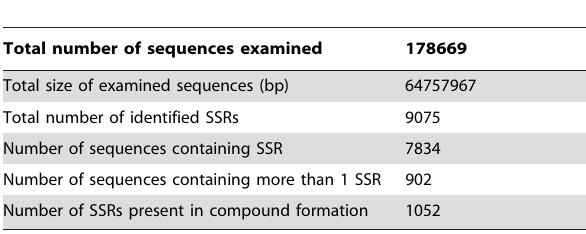
Table 2. Summary of microsatellite loci predicted in B.tabaci